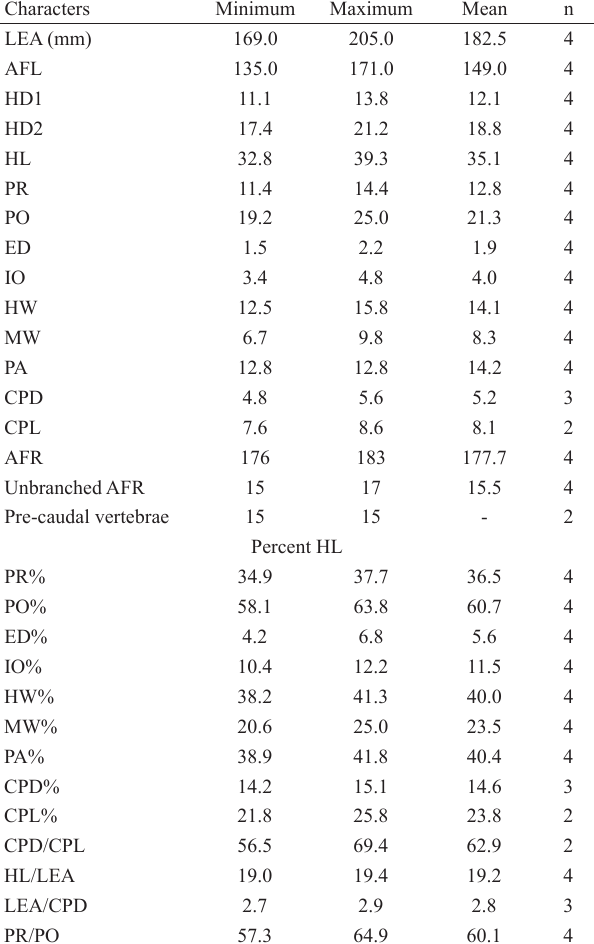
Tab. 8. Morphometrics and meristic measurements for Sternarchella raptor .